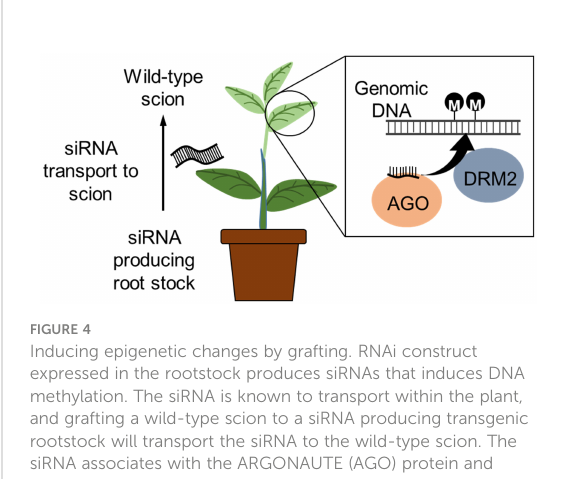
FIGURE 4 Inducing epigenetic changes by grafting. RNAi construct expressed in the rootstock produces siRNAs that induces DNA methylation. The siRNA is known to transport within the plant, and grafting a wild-type scion to a siRNA producing transgenic rootstock will transport the siRNA to the wild-type scion. The siRNA associates with the ARGONAUTE (AGO) protein and induces de novo DNA methylation via the RdDM pathway. The wild-type scion will be non-transgenic (free of transgene integration into the